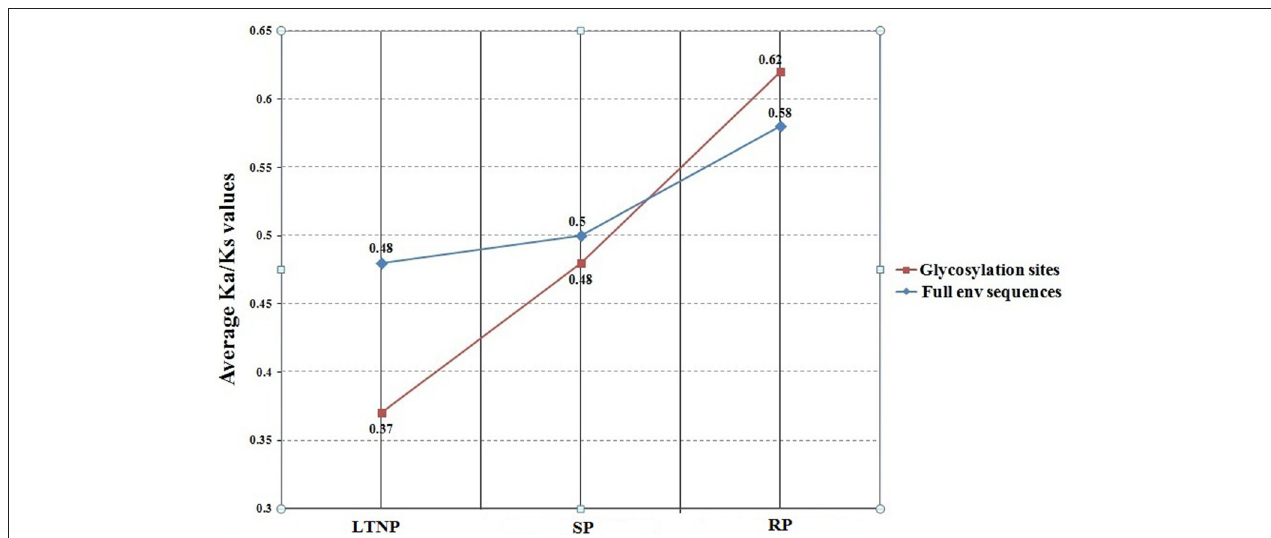
FIGURE 3 | Variation of Ka/Ks of env genes (LTNP, SP and RP) and respective glycosylation sites. LTNP, Long term non-progressor; SP, Slow progressor; RP, Rapid progressor. The blue line refers to the plot of the average Ka/Ks values of the full env sequences of LTNP, SP, and RP. The red line represents the plot of the average Ka/Ks values of the associated glycosylation sites of LTNP, SP, and RP.